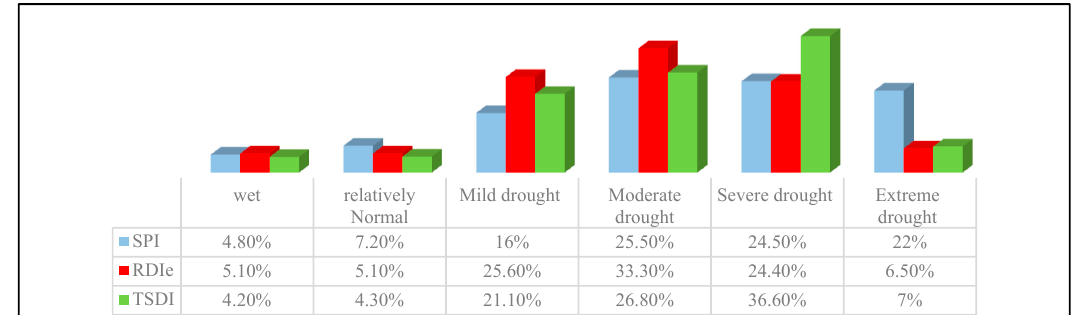
Figure 8. The percentage of area experiencing different drought intensities based on the SPI, RDIe, and TSDI.